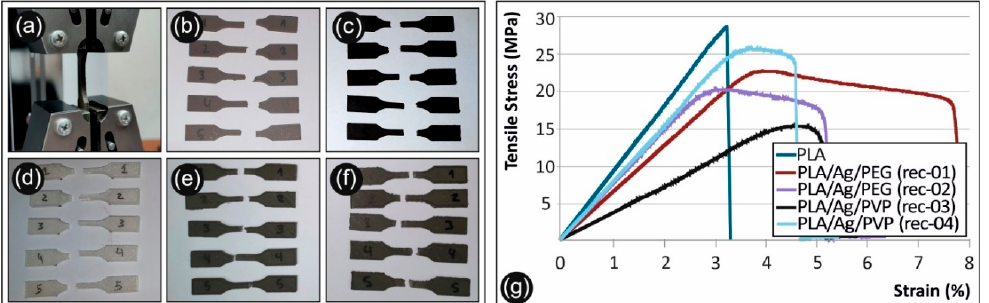
Figure 10. Comparative spider graphs for the antibacterial behavior for the four 3D printed PLA/AgNP nanocomposites produced in this work (with 100 µm 3D printed layer thickness) against ( a ) S. aureus and ( b ) E. coli after 30, 60, and 120 min of contact. Values are mean. Mean values do not differ significantly ( p < 0.05).